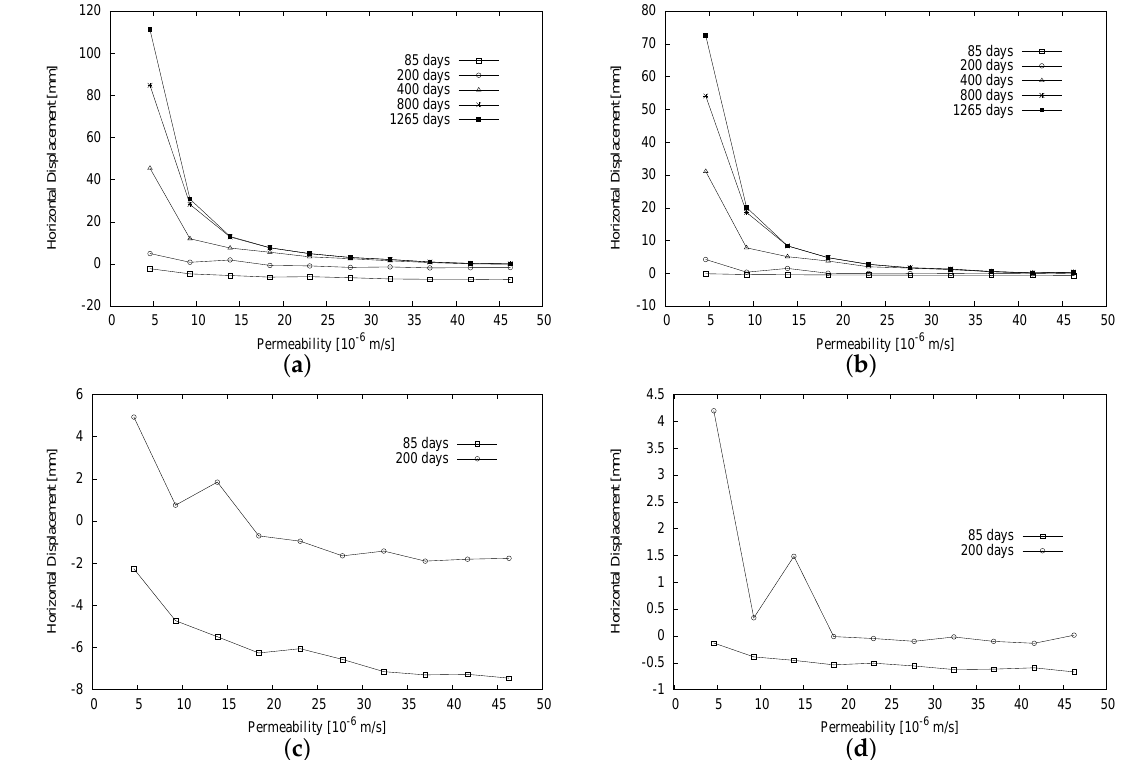
Figure 7. Influence of permeability of the sliding body to ( a ) horizontal displacement at G7, ( b ) horizontal displacement at G9, ( c ) horizontal displacement at G7 (after 85 and 200 days), ( d ) horizontal displacement at G9 (after 85 and 200